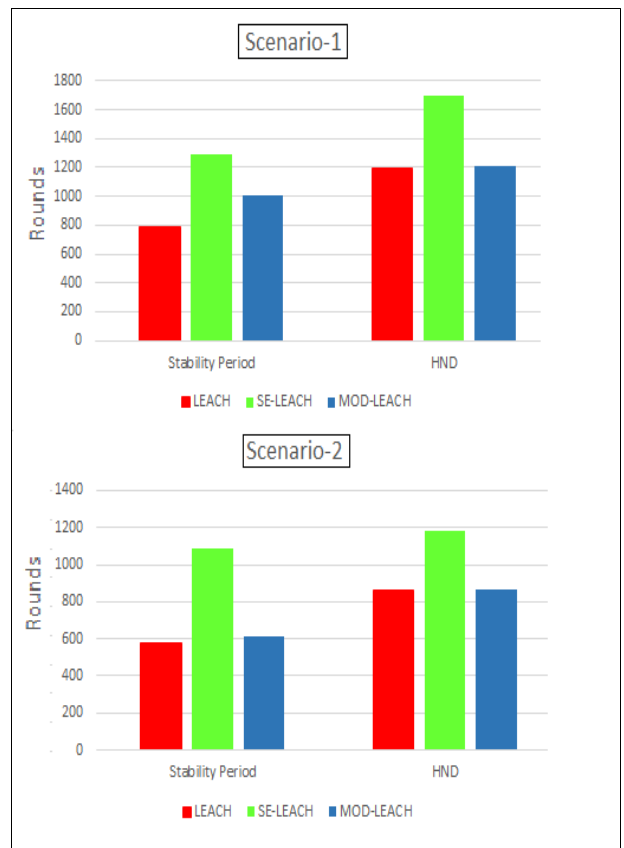
Figure 6. Stability period & Half Node Death